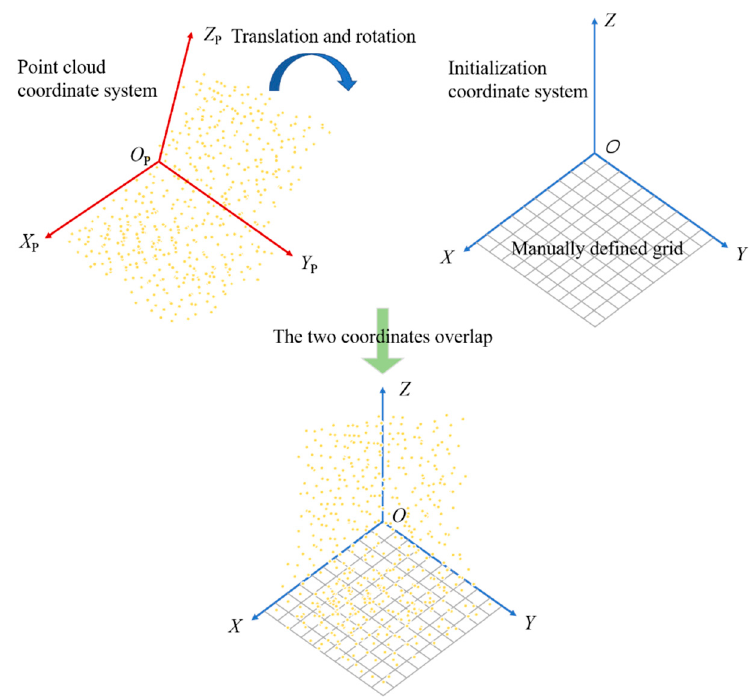
Figure 2. Schematic diagram of the meshing grid.